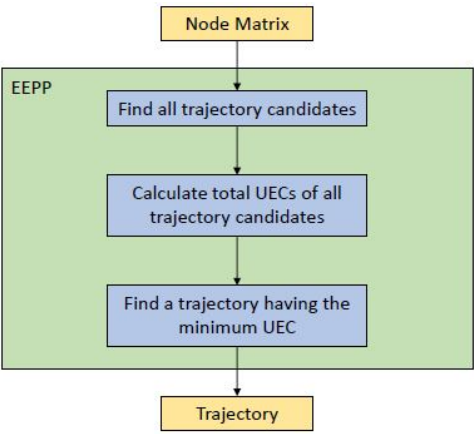
ffi cient path planning (EEPP) algorithm. Figure 5. Flowchart of the energy-efficient path planning (EEPP) algorithm. Figure 5. Flowchart of the energy-e